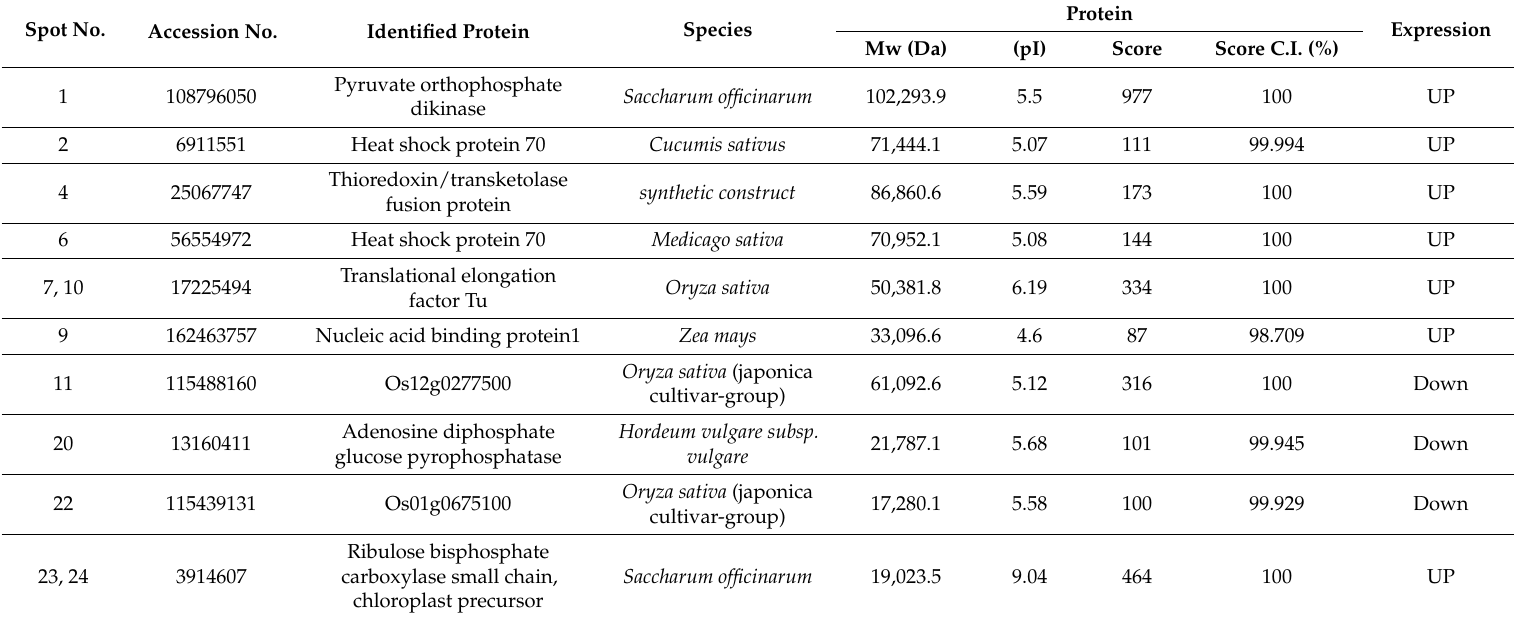
Spot numbers matched up to 2-DE gel in Figure 1; Expression relation was measured comparative to protein expression in control